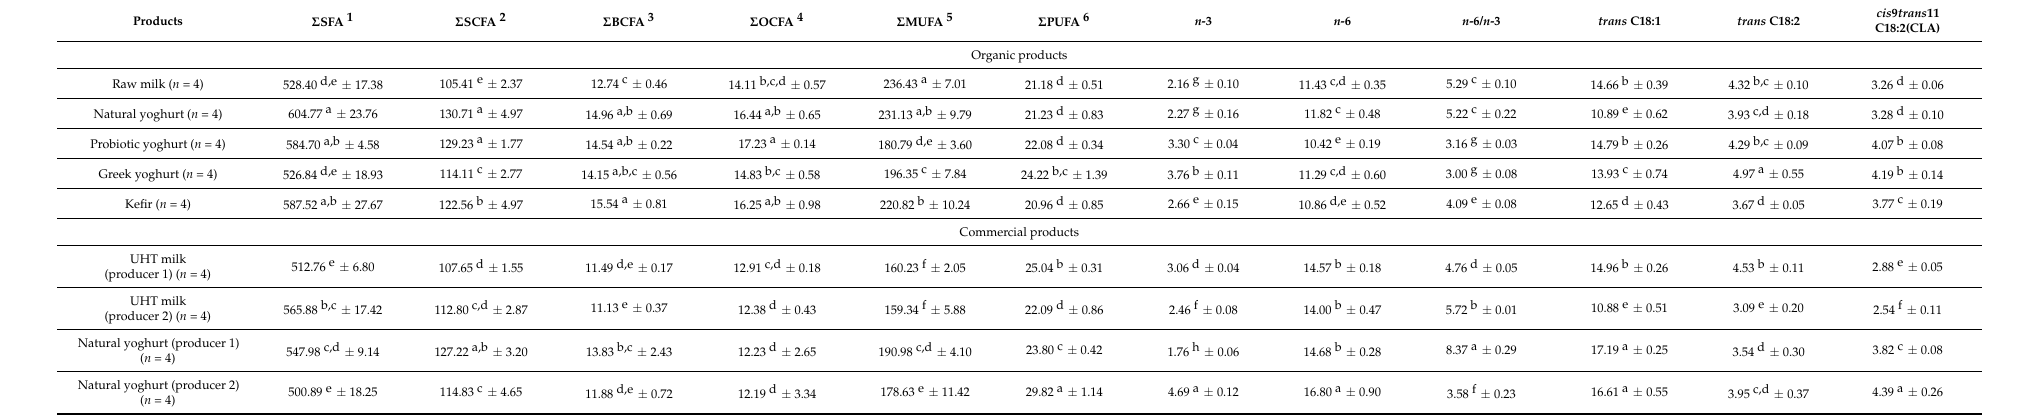
Table 2. Content of fatty acid groups (mg/g fat) in fat from goat’s milk and fermented goat’s milk drinks (Mean ±